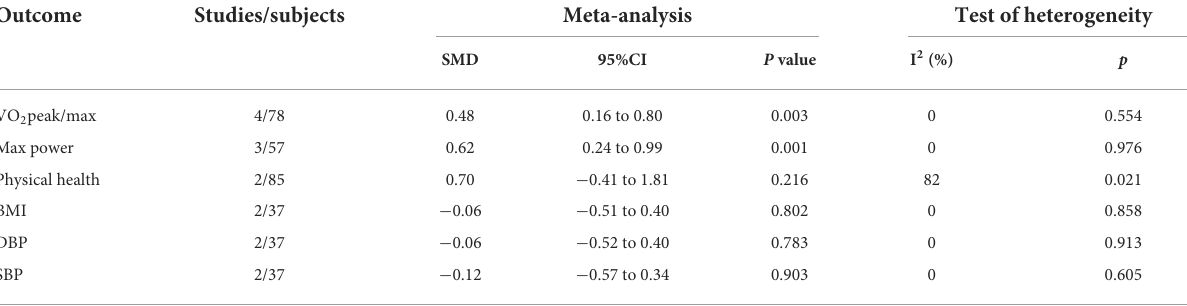
TABLE 2 Meta-analysis for the effect of E-cycling on health outcomes. Outcome